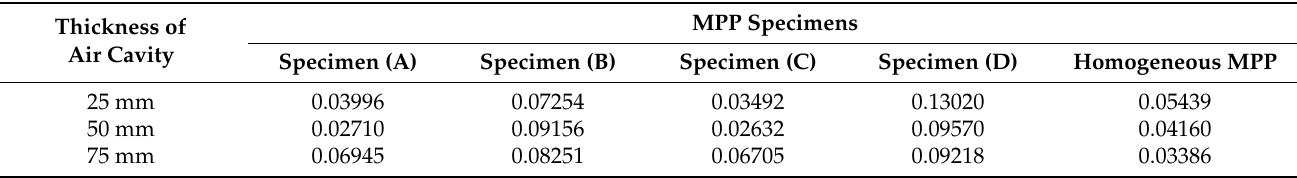
Table 2. RMS error in all conditions.